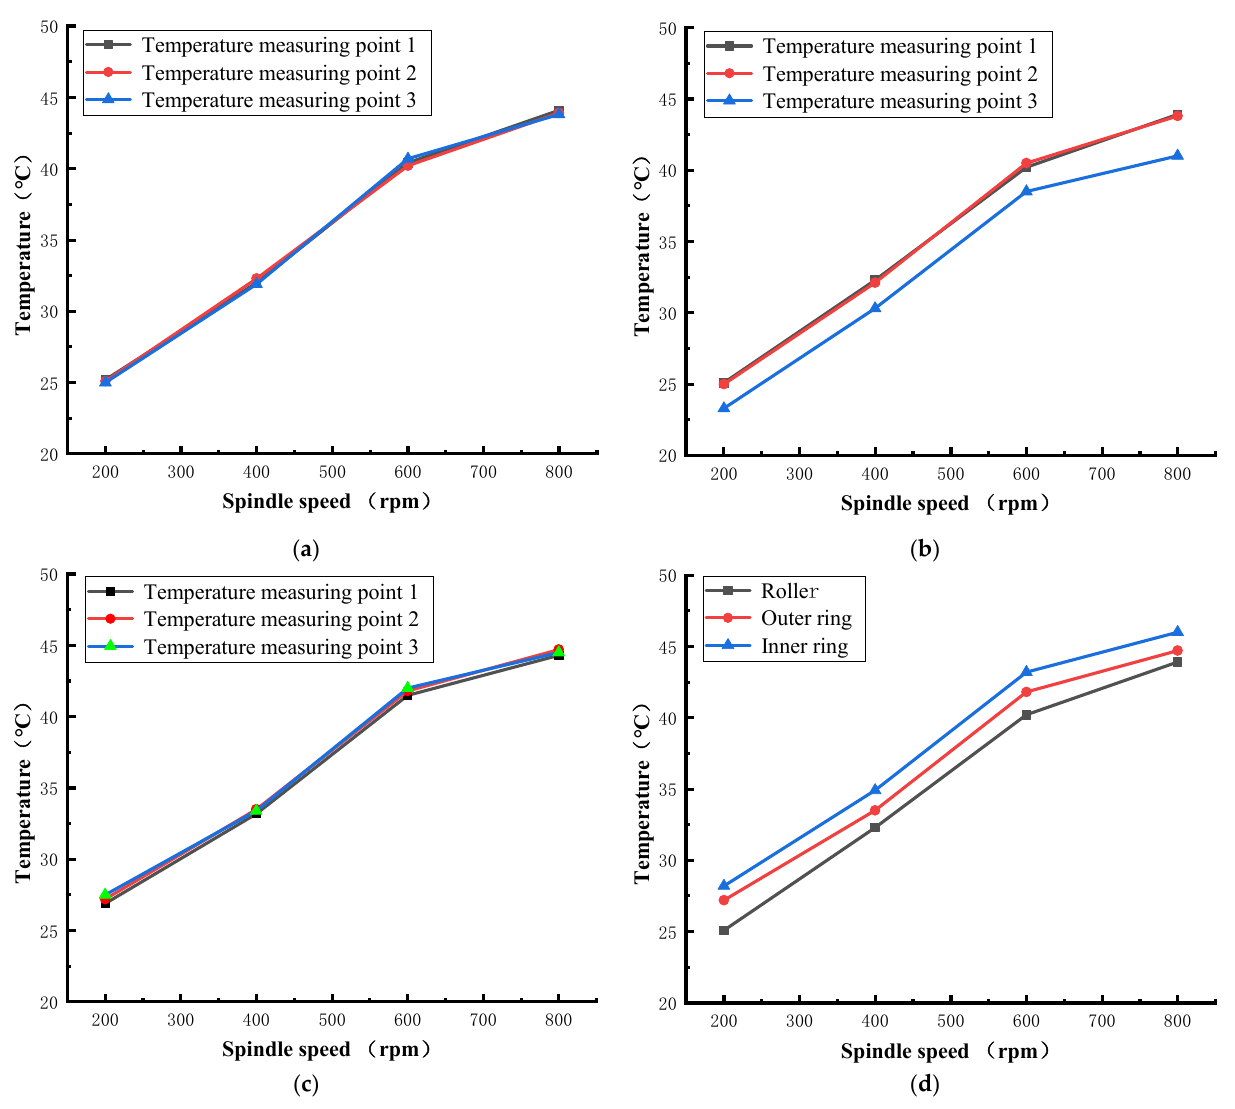
Figure 17. Temperature rise of railway bearing 353130B at different speeds: ( a ) circumferential direction of outer ring; ( b ) outer ring axial; ( c ) circumferential direction of inner ring; ( d ) radial bearing.